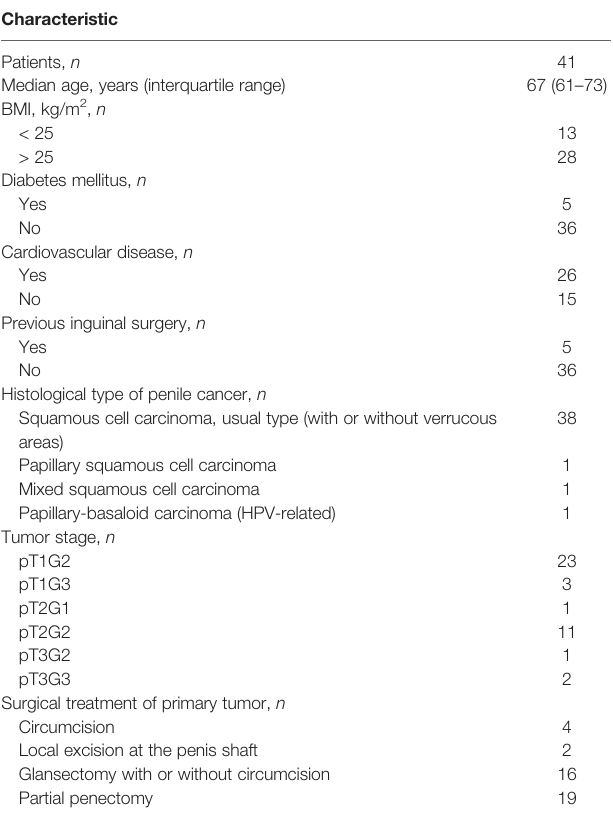
TABLE 1 | Patient and tumor characteristics.